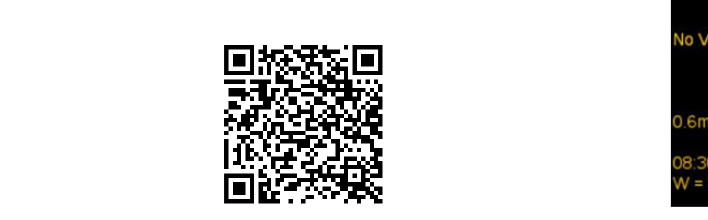
Fig. 3 – At 3 months postoperatively, the closure of the fistulae was confirmed by 128-slice computed tomography